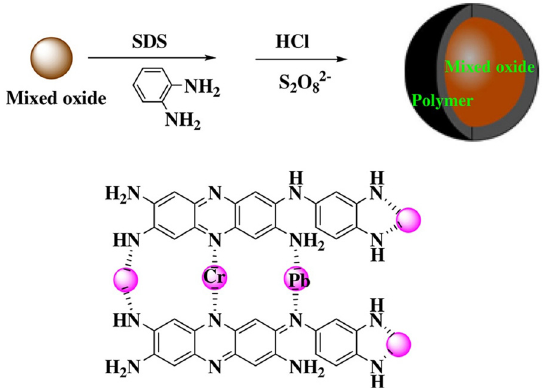
Figure 3: Schematic illustration of MgAl@CaFe 2 O 4 – poly o - phenyle - nediamine composite fabrication. Reproduced with permission from ref. [ 89 ] ; copyright ( 2016 ) ,